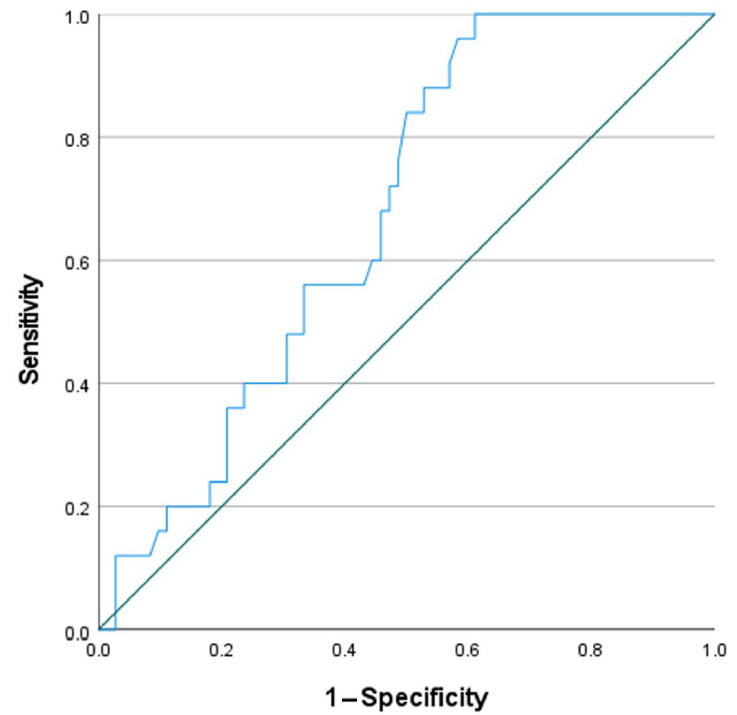
Figure 3. ROC curve showing sensitivity and specificity of WBC count at admission and occurrence of cerebral vasospasm ( p = 0.006).